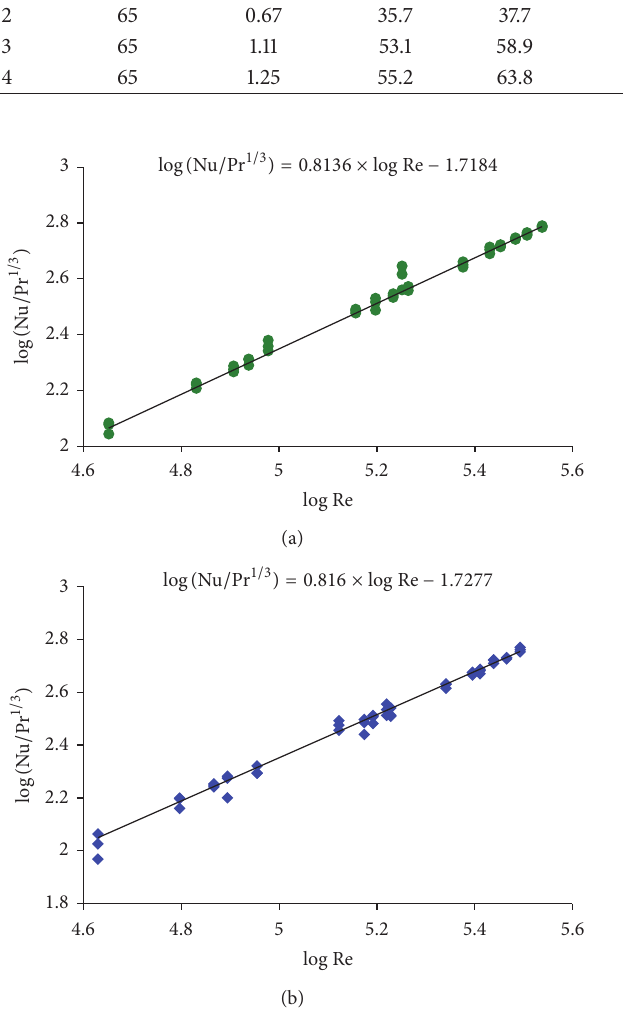
Figure 5: The linear relationship of log ( Nu / Pr 1/3 ) versus log ( Re ) for the (a) pure and (b) saline water.